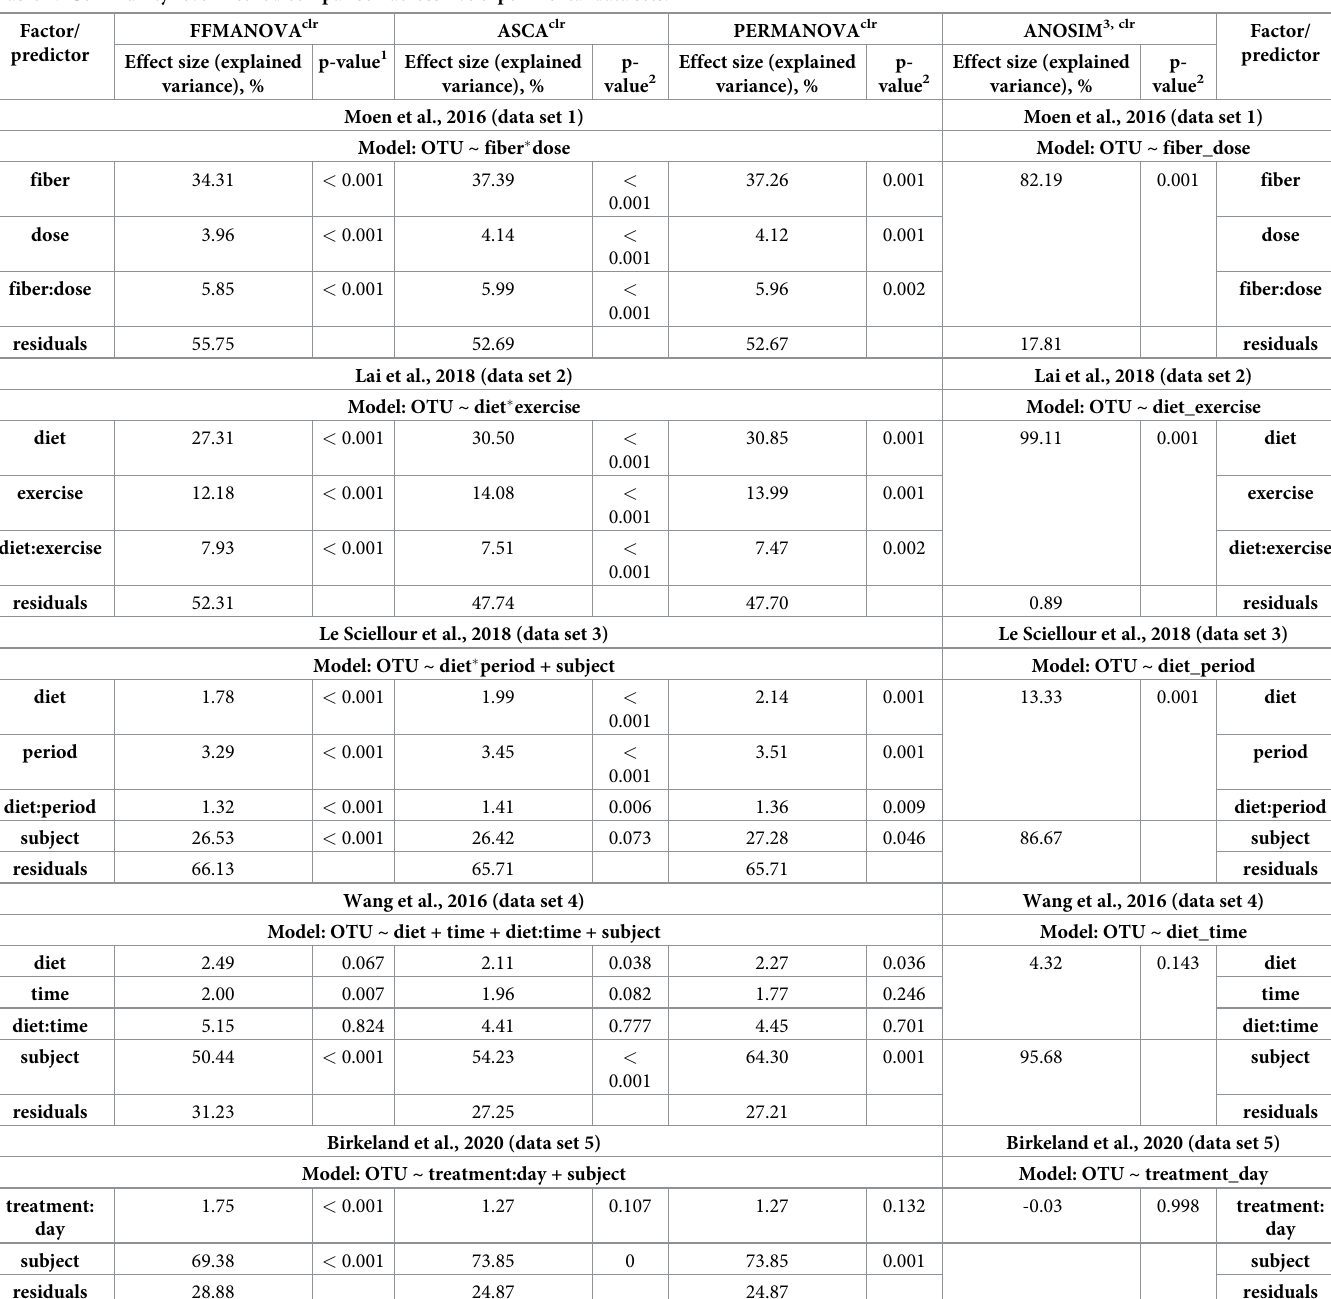
Table 2. Community-level method comparison across five experimental data sets. Factor/